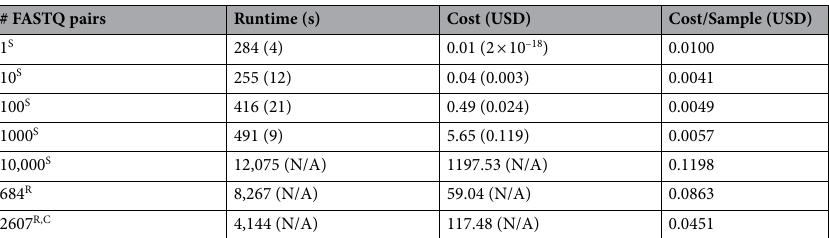
Table 2. Benchmark of ViReflow. ViReflow was executed on 1, 10, 100, 1 K, and 10 K random 1000X depth sub-samplings of the single highest-depth sample from a NovaSeq SARS-CoV-2 amplicon sequencing run (denoted with S ). ViReflow was also executed on two real NovaSeq runs (denoted with R ), one of which was capped at 2 million successfully-mapped reads for each sample (denoted with C ). All executions were run single-threaded. Total runtime (seconds) and total cost (US Dollars) across 10 technical replicates are shown as Mean (SD) pairs. “N/A” denotes single replicate execution due to high per-replicate compute costs. Specific details of tool choices (with versions) for each step of the pipeline can be found in the “Methods”